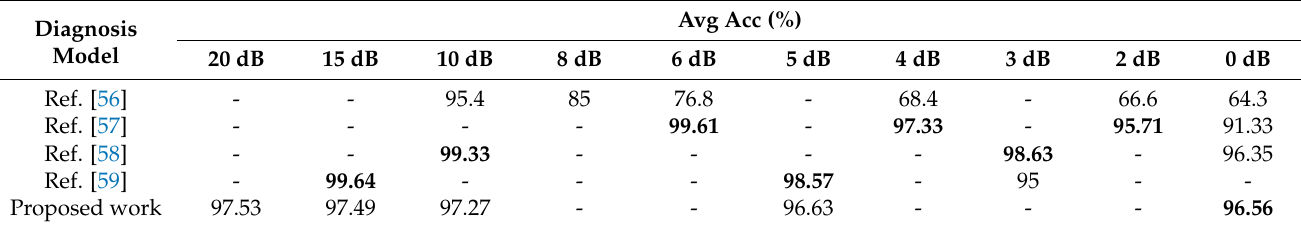
Table 17. Comparison with published in literature for bear.ng fault diagnosis models in noisy condition. Diagnosis